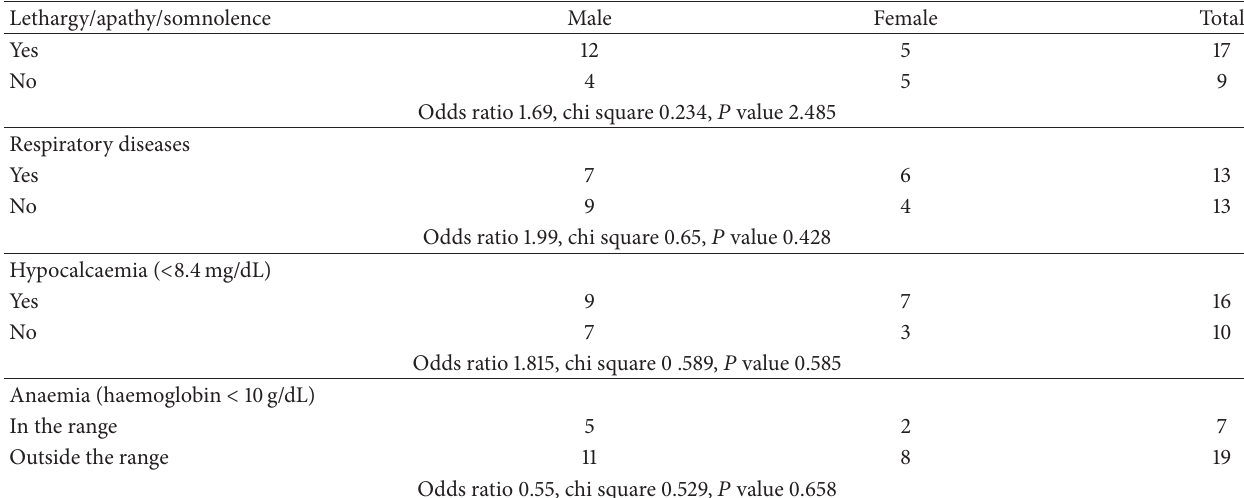
Table 4: Gender-wise odd ratio analyses for clinical and laboratory